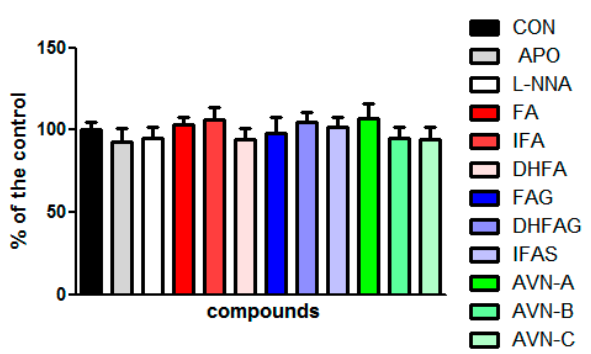
Figure 2. HUVEC cell viability measured with the LDH assay, after pre-treatment with the oat phenolics and metabolites (1 µ M) ferulic acid (FA) isoferulic acid (IFA), dihydroferulic acid (DHFA), FA glucuronide (FAG), DHFA glucuronide (DHFAG), IFA sulfate (IFAS), avenanthramide A (AVN-A) avenanthramide B (AVN-B) avenanthramide C (AVN-C), apocynin (APO, 100 µ M) or L-NG-Nitro-Arginine (L-NNA, 100 µ M) for 24 h. Data are expressed as percentage of control (CON) values (100%) and reported as average ± SEM of 4 independent experiments performed in triplicate. p > 0.05 vs. control ( n = 12).